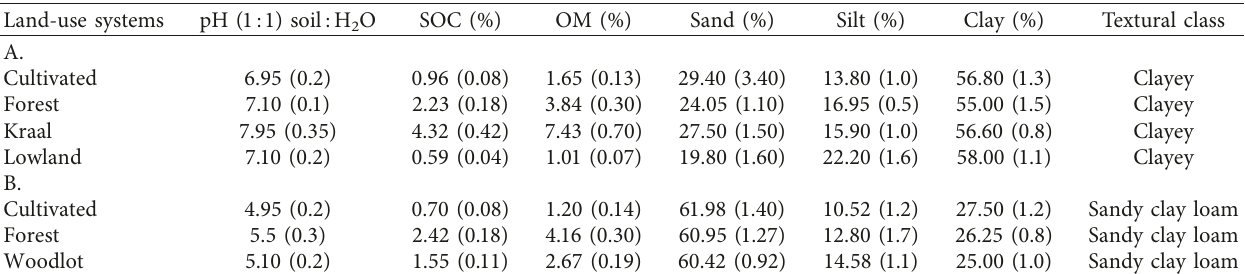
Table 2: Initial soil chemical and physical properties of land-use systems at SIREC-Kpong (A) and Legon, University of Ghana (B). Land-use systems